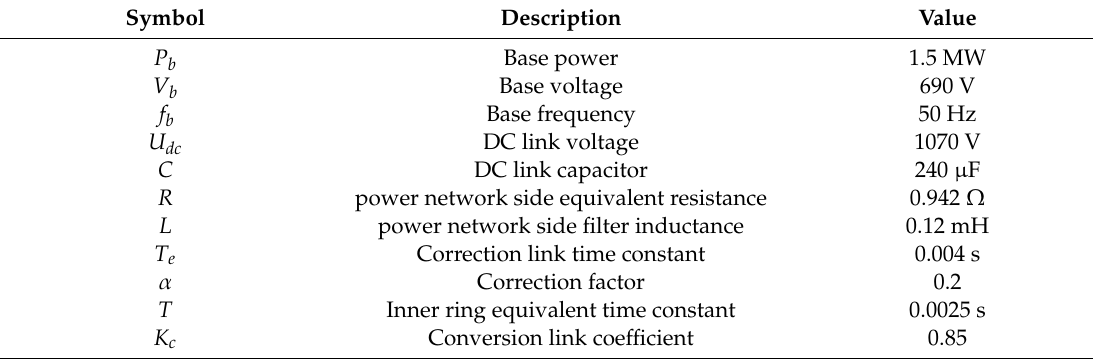
Table A1. Main parameters of PMSG.